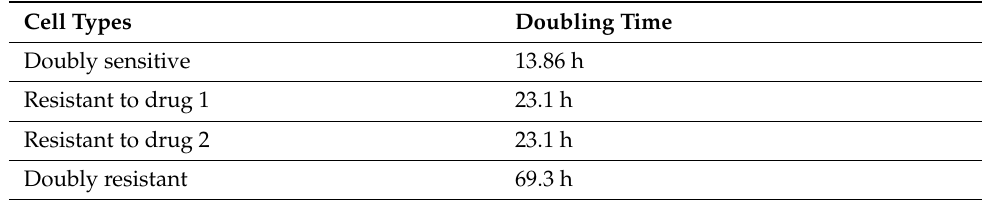
Figure 6. Effect of turnover on outcome of adaptive therapy with 2 drugs. The panels show the comparison of adaptive therapy (AT) versus standard treatment (ST) as turnover is varied while keeping the doubling time and net growth rate identical for ( A ) DM Cocktail Tandem, ( B ) DM Ping-Pong Alternate Every Cycle, ( C ) DM Ping-Pong on Progression, ( D ) FD Dose-Skipping/Drug- Holiday, ( E ) FD Intermittent. For low turnover (LT) conditions, the death rate was half of the default, at 0.005/h for all cell types, while for high turnover (HT) conditions, the death rate was twice the default at 0.02/h for all cell types. Division rates were set for each cell type to keep the fitness differences (net growth rates) the same as the default conditions. The dose modulation protocols worked well regardless of the amount of turnover. High cell turnover led to statistically significantly improved TTP in ST, DM Cocktail Tandem, and though the effect size was small, in both FD protocols. Table 2. Doubling time of the cell